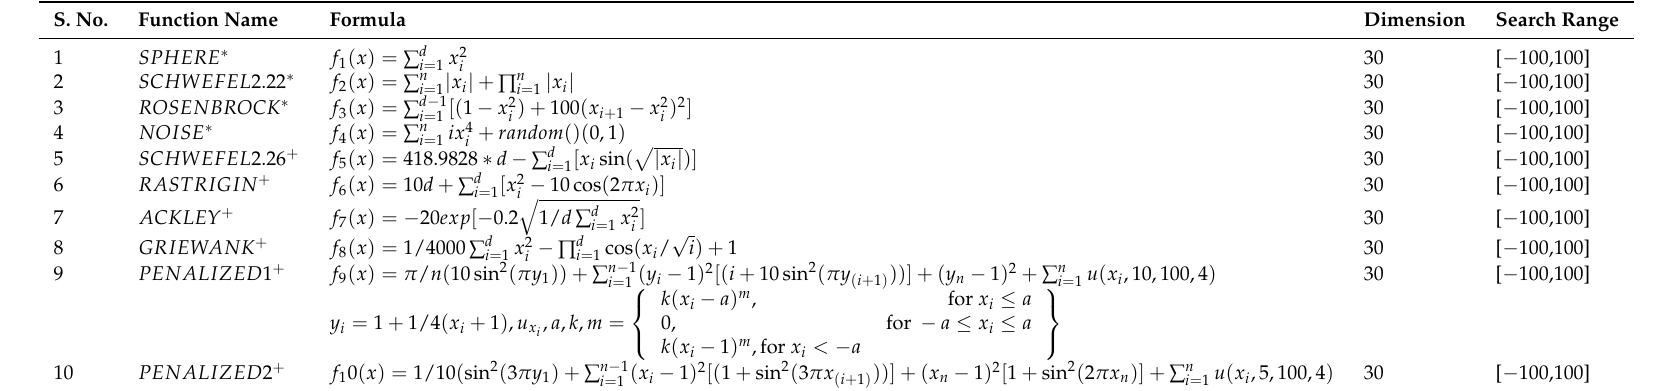
Table 2. Benchmark